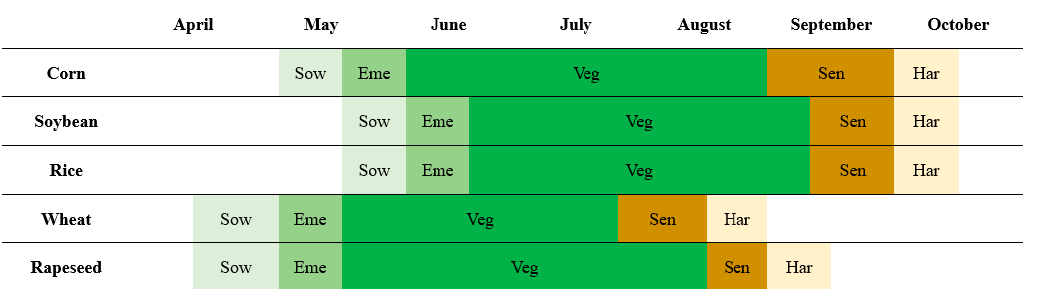
Figure 1. The location of ( a ) Inner Mongolia Autonomous Region (shaded area) of China, ( b ) the